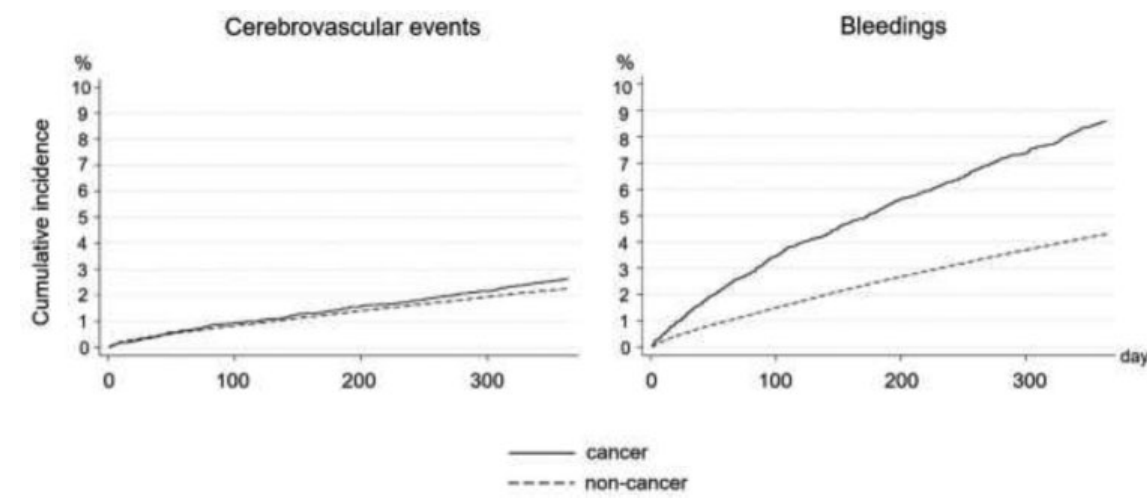
Fig. 1 OAC-treated patients with atrial fi brillation, cancer versus noncancer patients: unadjusted cumulative incidences of cerebrovascular events and all bleedings during fi rst year after OAC initiation, accounting for the competing risk of death. OAC, oral anticoagulant.